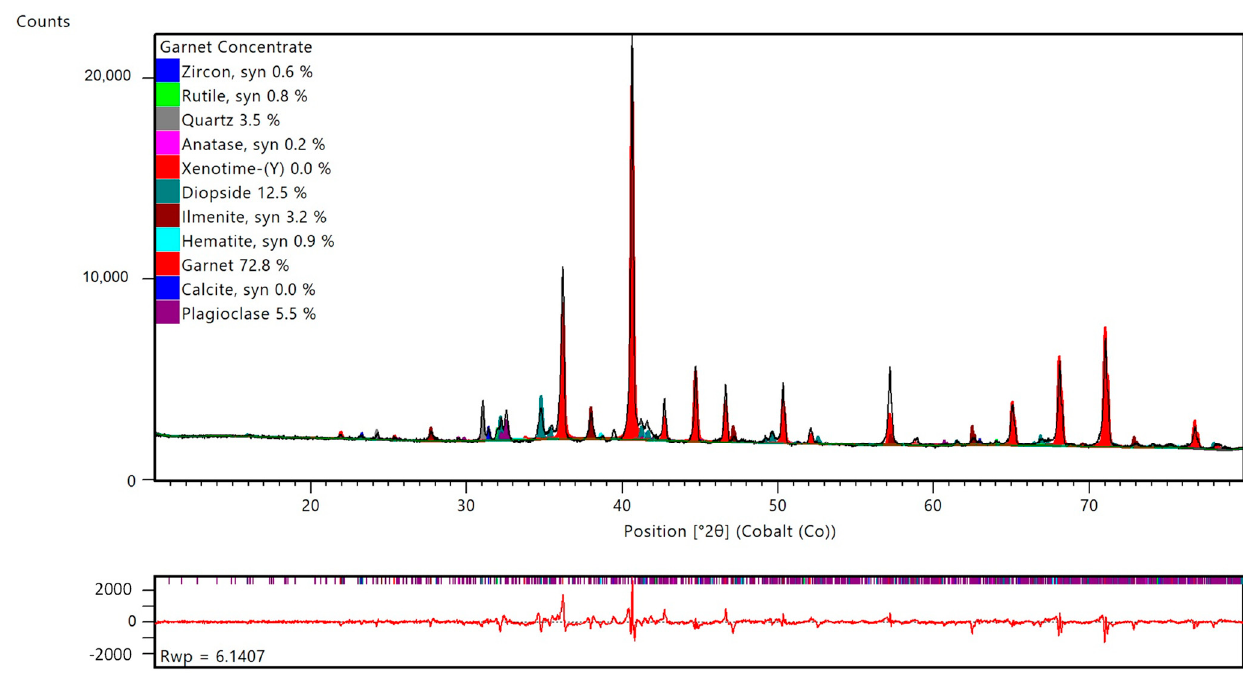
Figure 7. Typical garnet concentrate. Rietveld quantification ( top ) including difference plot between measured and calculated profiles as well as the R wp ( bottom ).